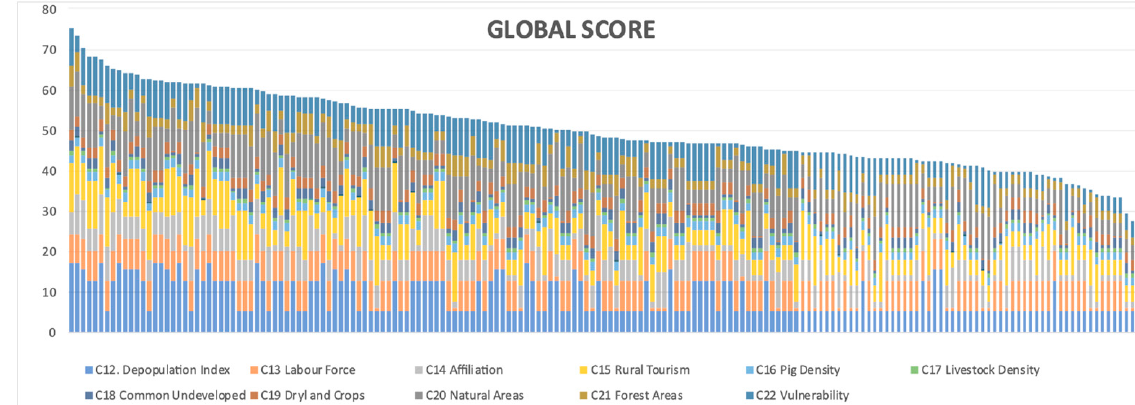
Figure 9. Score of 178 municipalities with suitable pig areas.